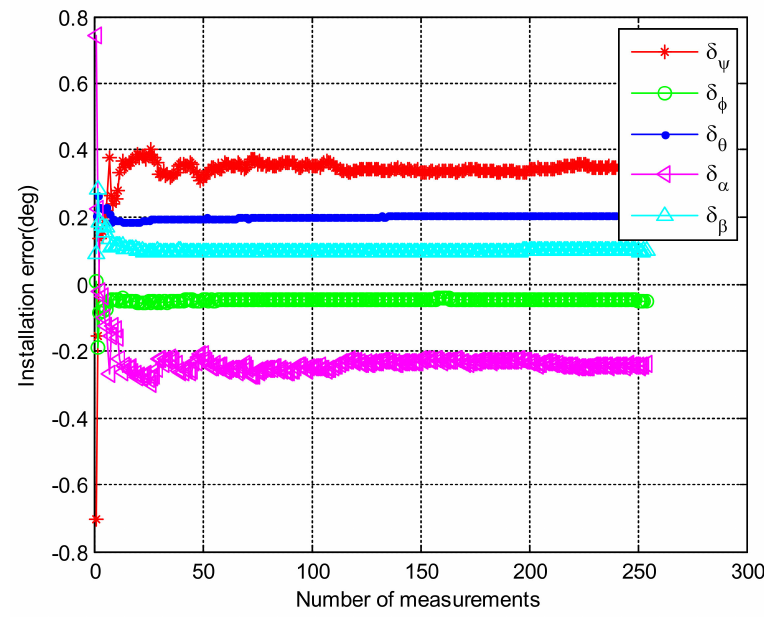
Figure 7. The iteration curve of the installing errors for simulation